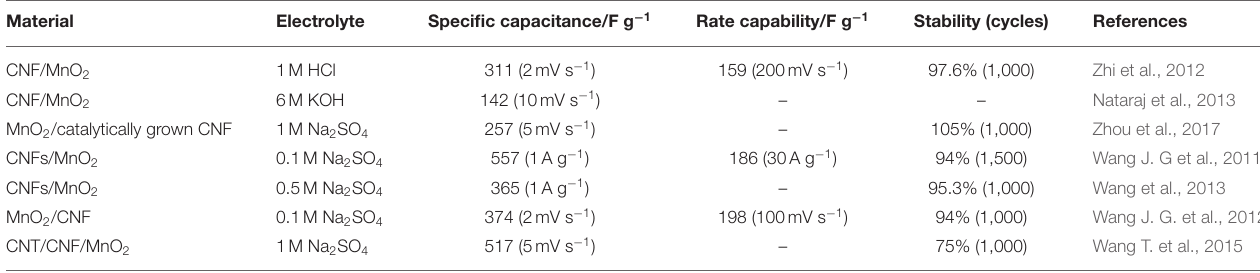
TABLE 3 | Electrochemical performance of various MnO 2 /CNF material.